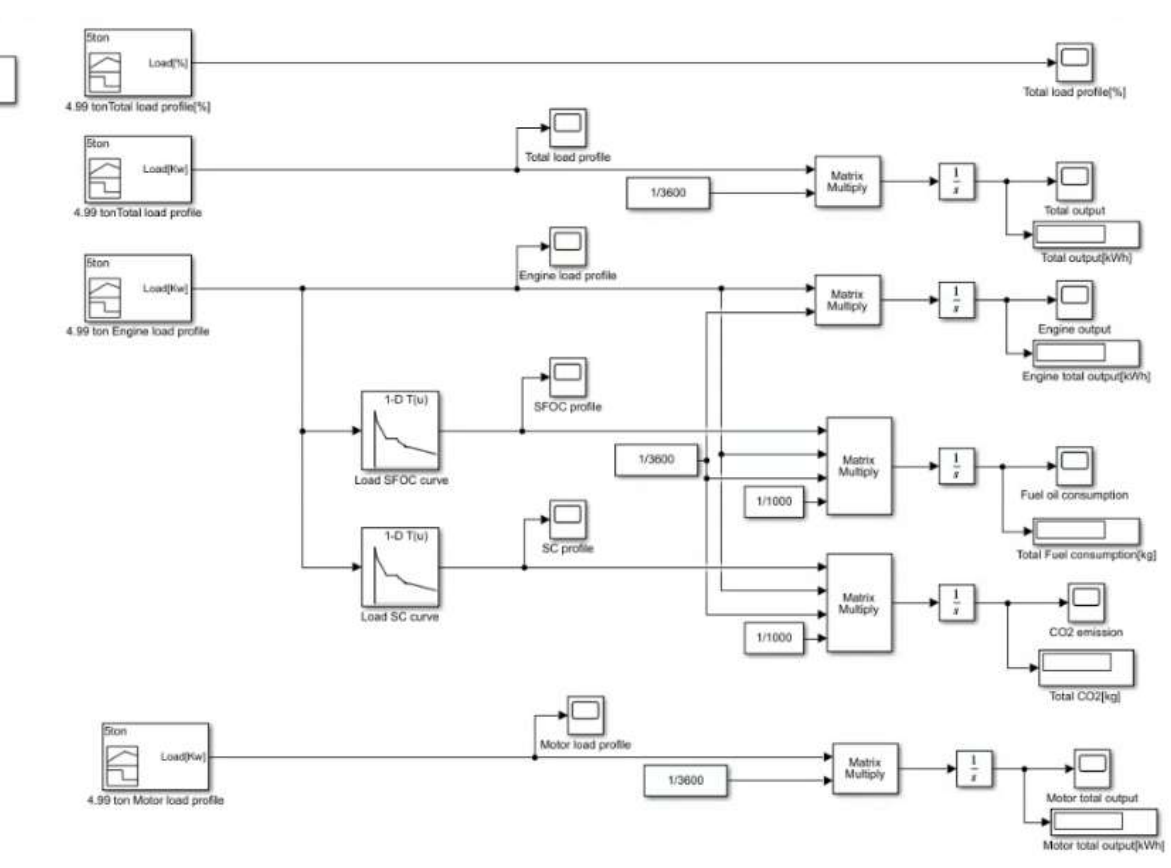
Figure 6. Economic and environmental analysis tool.